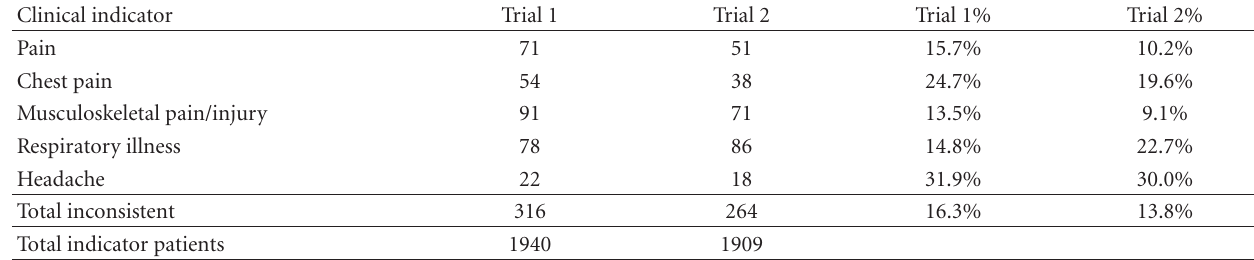
Table 6: Frequency of clinical indicator Canadian Triage and Acuity Scale (CTAS) inconsistency compared with NR (inconsistency, inconsist- ency/total: Table 5 as %).